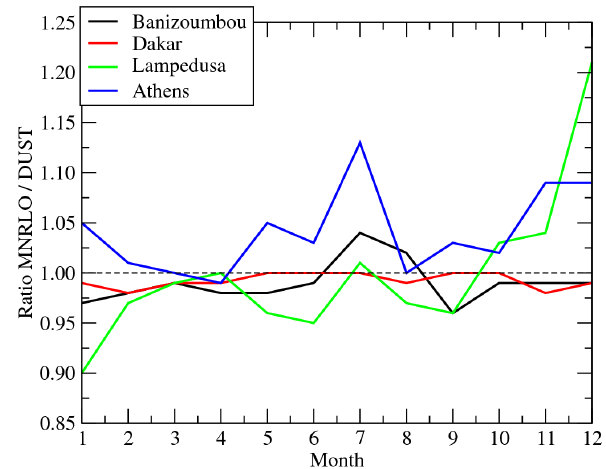
Figure 5. Surface concentrations ratios (ad. – dimensionless) be- tween MNRLO and DUST and for four sites: Banizoumbou, Dakar, Lampedusa and Athens.